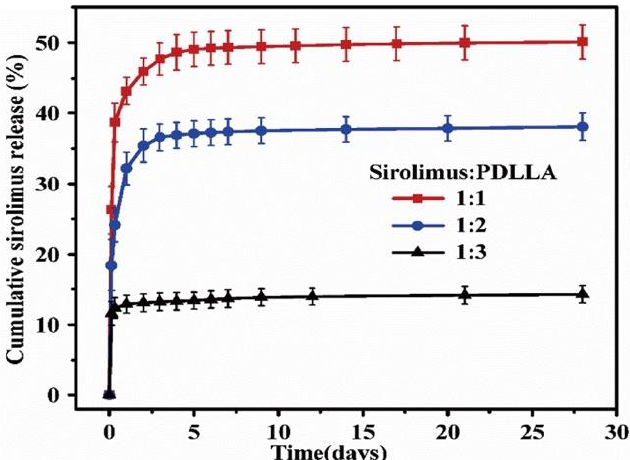
Figure 5. Cumulative sirolimus release profiles for poly-D,L-lactic acid (PDLLA) coatings with three different drug/polymer ratios in phosphate buffered saline solution at 37 °C. Adapted with permission from [51]; published by Elsevier, 2018.